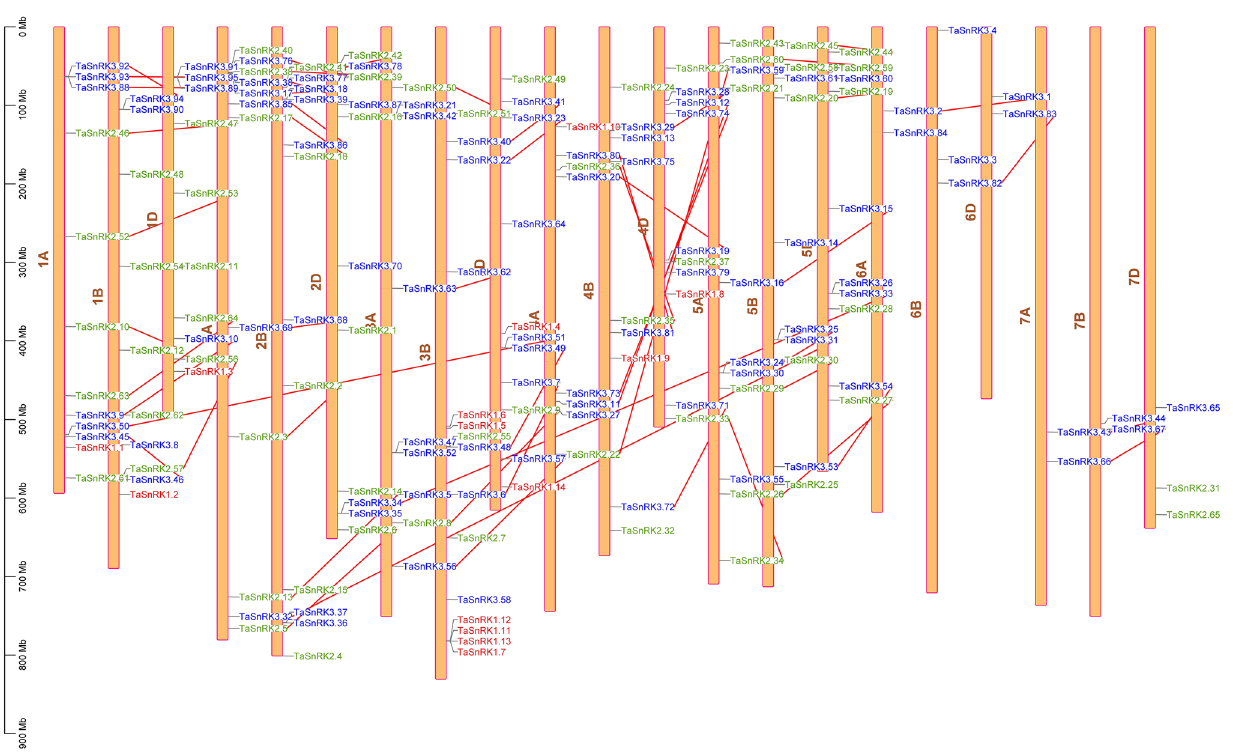
Figure 3. Distribution of TaSnRK genes on the 21 chromosomes of wheat and within the three sub-genomes. Black lines representing the gene pairs. Physical map showing the chromosomal distribution, with position on the left side scale bar and the name of the gene on right